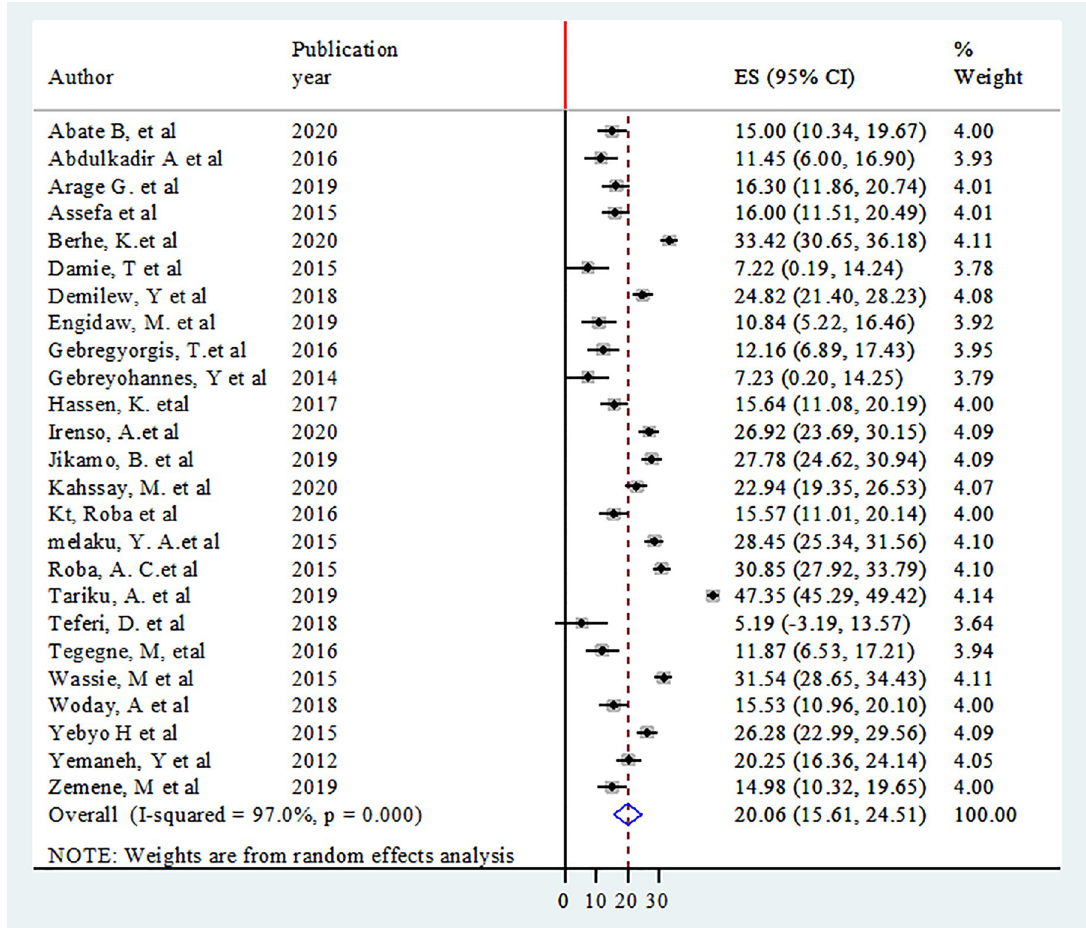
Fig 3. Forest plot of the pooled prevalence of adolescent stunting in